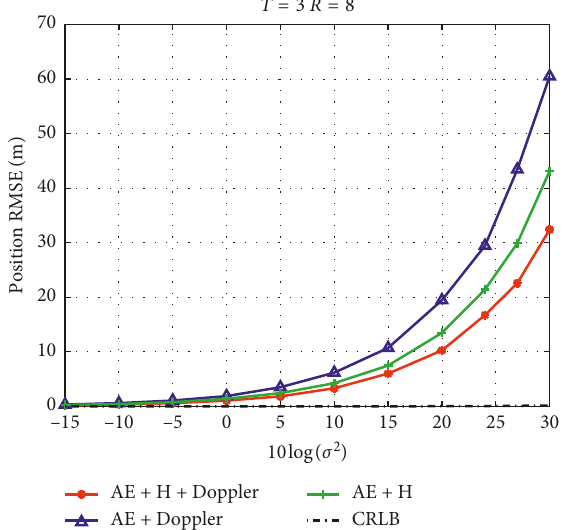
Figure 3: Comparison of the position RMSE of the proposed method with AE +Doppler, AE+H, and CRLB when T � 3, R � 8. The CRLB is close to zero, but it is going up as the noise power increases.